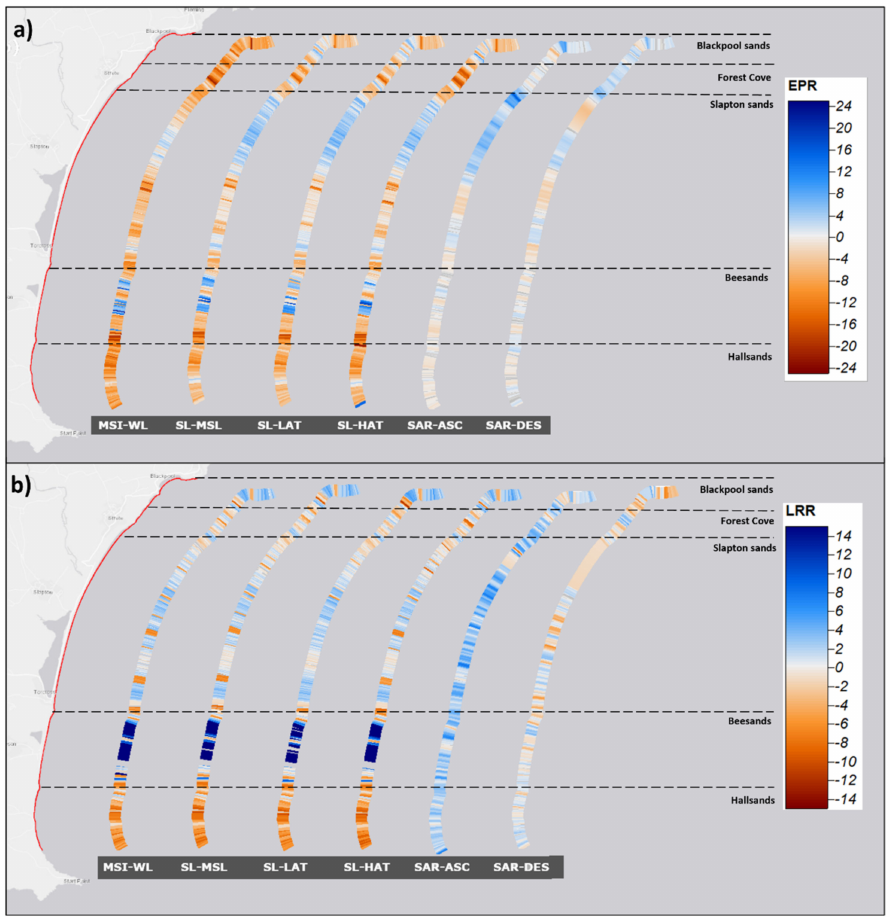
Figure 14. Coastline change rate values End Point Rate (EPR) ( a ) and Linear Regression Rate (LRR) ( b ) obtained for Start Bay (Site #3) using different MSI and SAR lines for the time period between 2016 and 2019. The color bar represents change rate intensity in m/year ranging from orange-brown (erosion) to blue (accretion), with no detectable change represented in white. Source of Light Gray Canvas Base map: Esri, HERE, Garmin, © OpenStreetMap contributors, and the GIS user